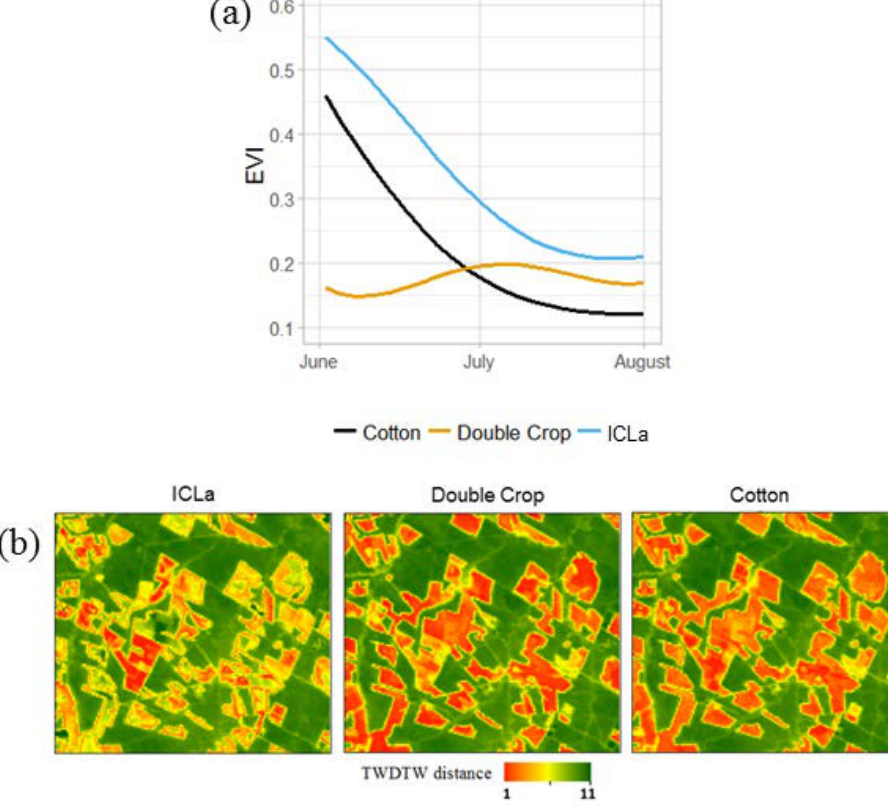
Figure 5. ( a ) Temporal patterns and ( b ) TWDTW distance subset for classes in Phase 2.